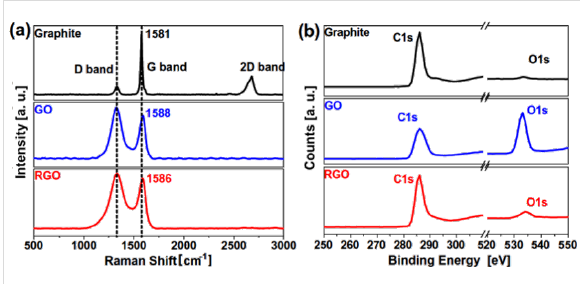
Figure 1: (a) Raman spectra and (b) XPS survey scans of graphite, graphene oxide and thermally reduced graphene oxide. Reproduced with permission from [13], copyright 2013